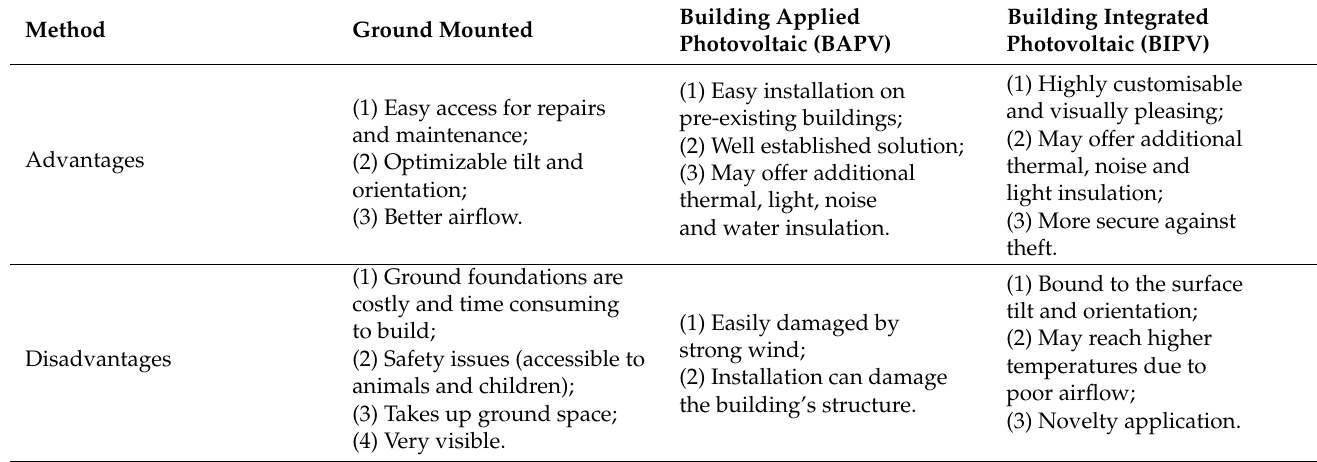
Table 2. Advantages and disadvantages of ground mounted, BAPV and BIPV